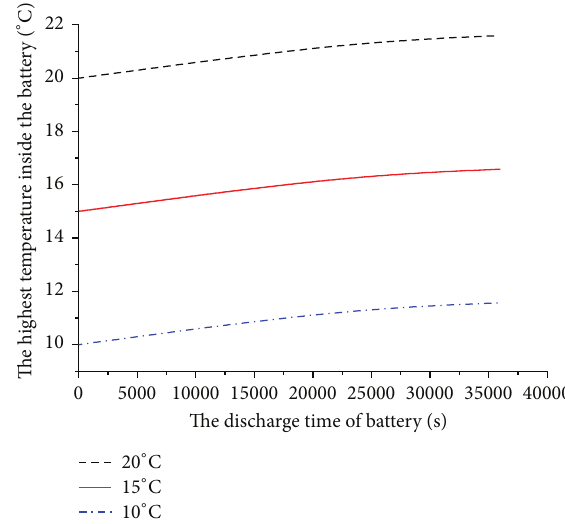
Figure 11: The battery compartment maximum temperatures over time when the speed is